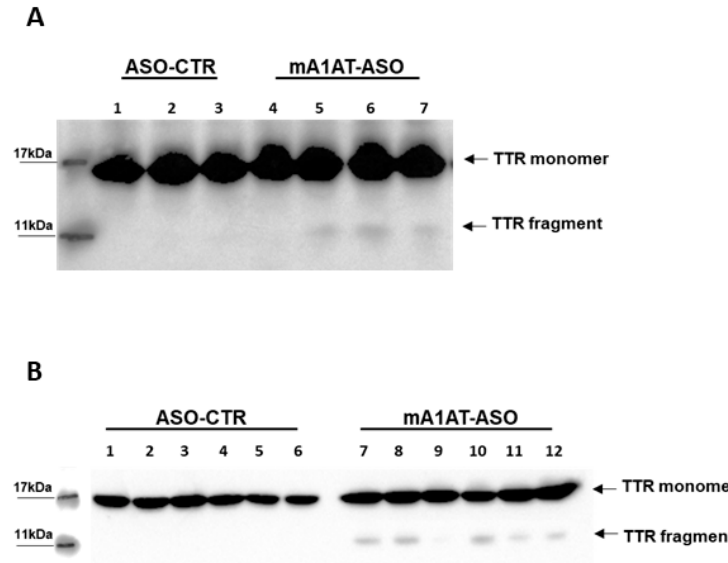
Figure 6. Western blotting analysis revealed the presence of transthyretin fragments upon SerpinA1 downregulation in the heart. Transthyretin fragments were detected in the heart of both older ( A ) and younger ( B ) animals.